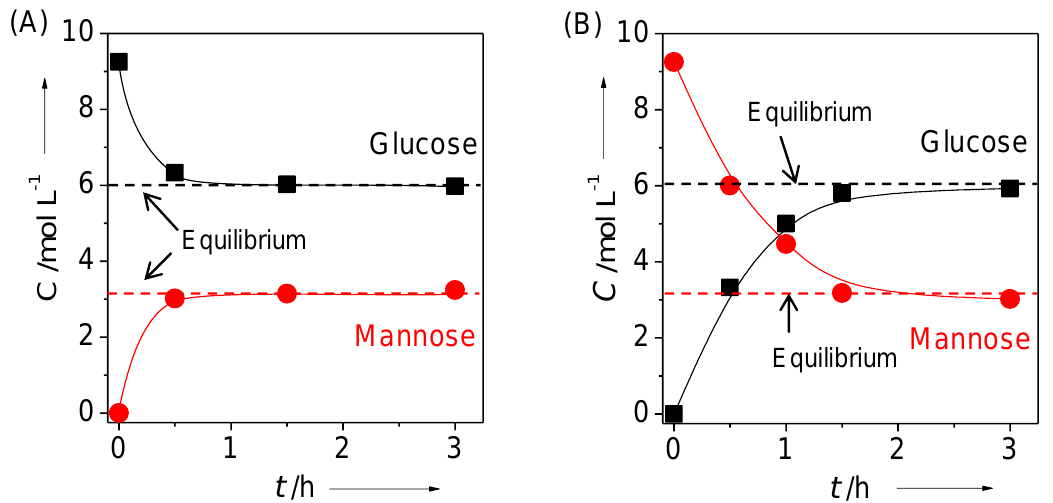
Figure 7. Time courses of epimerization of ( a ) glucose and ( b ) mannose over layered LiNbMoO 6 . Reaction conditions: Glucose (50 mg, 0.28 mmol), catalyst (50 mg), H 2 O (3 mL), 373 K. Reproduced with permission from [22]; copyright (2015), John Wiley & Sons, Inc.